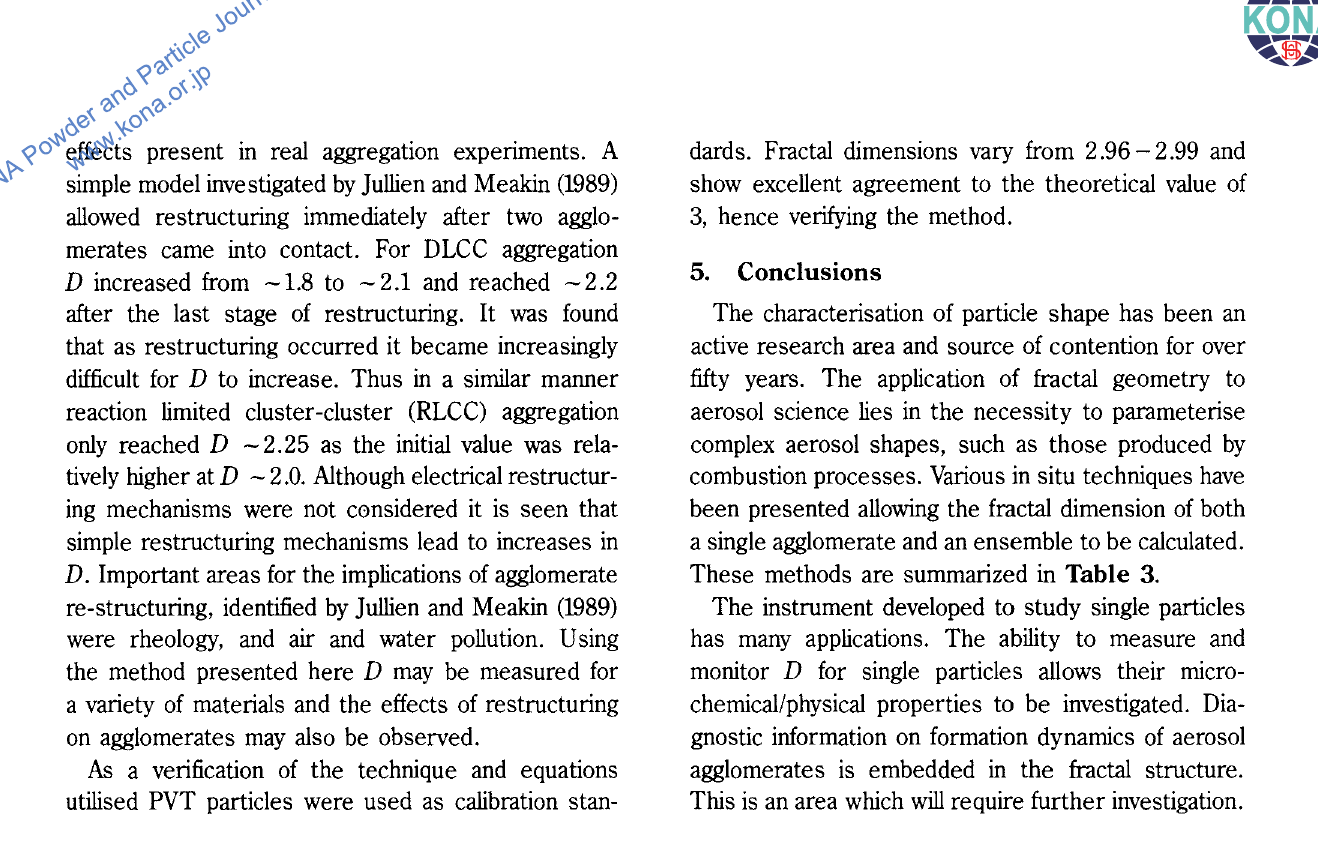
Table 3 Summary of in situ techniques used to measure the fractal dimension of aerosols